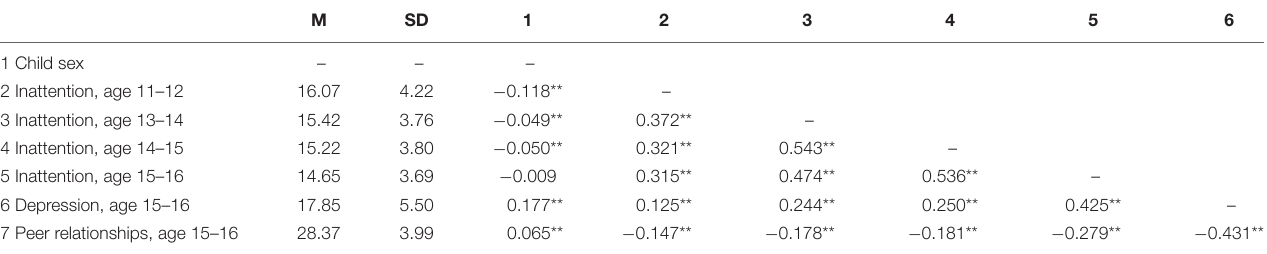
TABLE 2 | Descriptive statistics and bivariate correlations (Panel